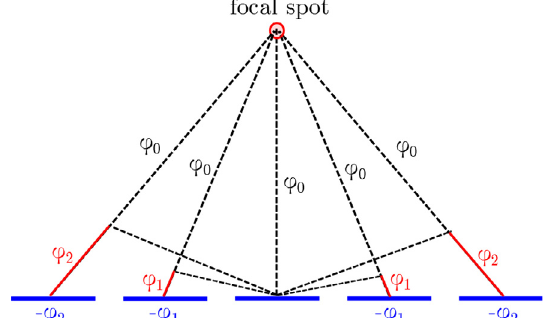
Figure 6. The central element has a free space path delay of u 0 . The adjacent elements have additional free space path delays of u 1 and u 2 . By rotating the corresponding unit cells with phase delays of (cid:2) u 1 and (cid:2) u 2 , the path delays can be compensated and the transmitted waves from each unit cell will arrive at the focal spot in phase.